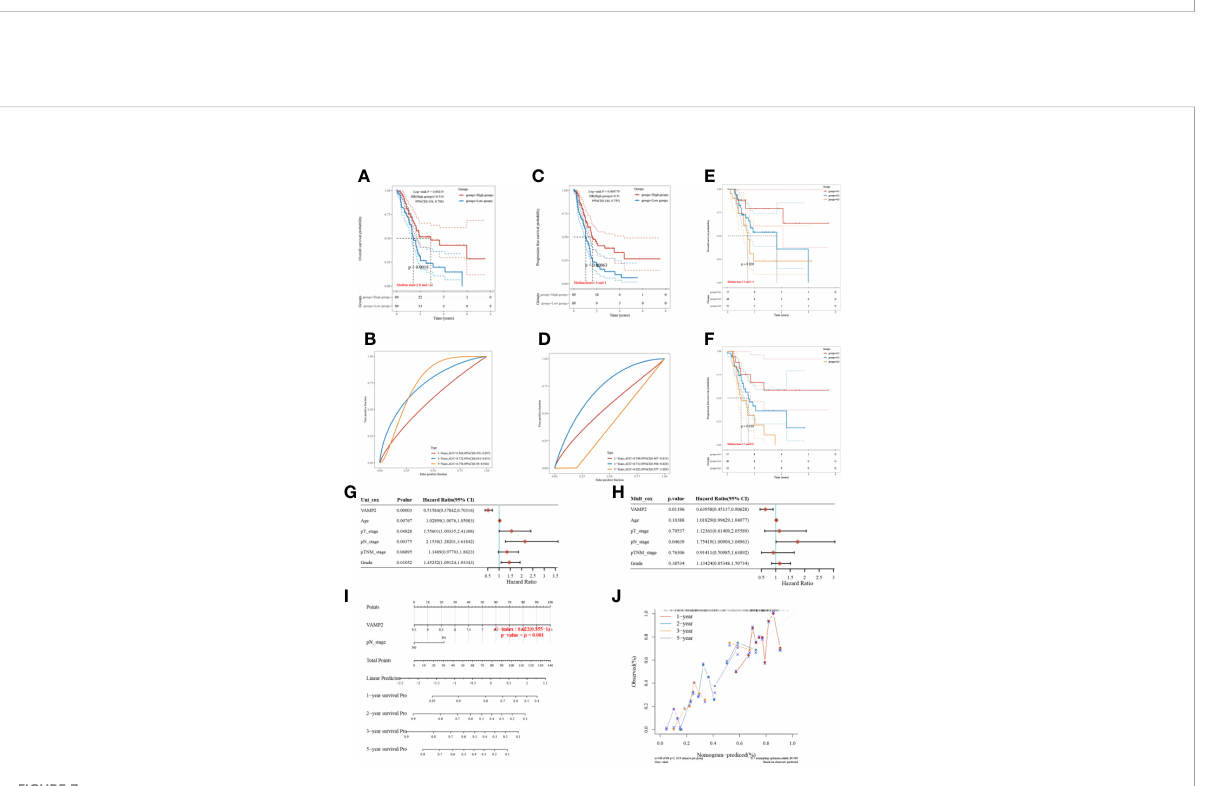
FIGURE 7 Prognosis of VAMP2. (A, B) : OS; (C, D) : PFSKM survival curves and ROC prediction model; (E, F) : KM curves for different tumor grades with OS and PFS, respectively; (G, H) : single-factor Cox regression analysis and multi-factor Cox regression analysis based on OS; (I) : column line graph; (J) : calibration